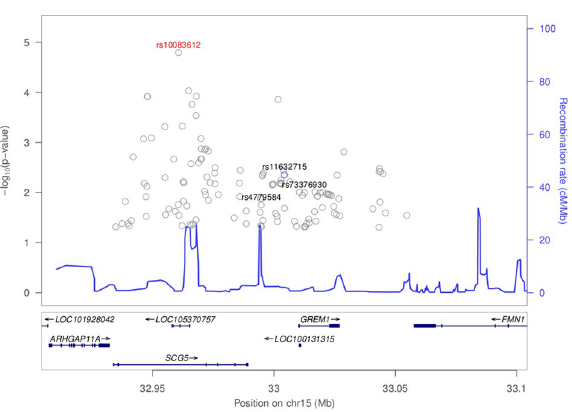
Figure 5. Association plot for 100 kb flanking rs11632715 on chromosome 15. The top associated SNP in the region was rs10083612.